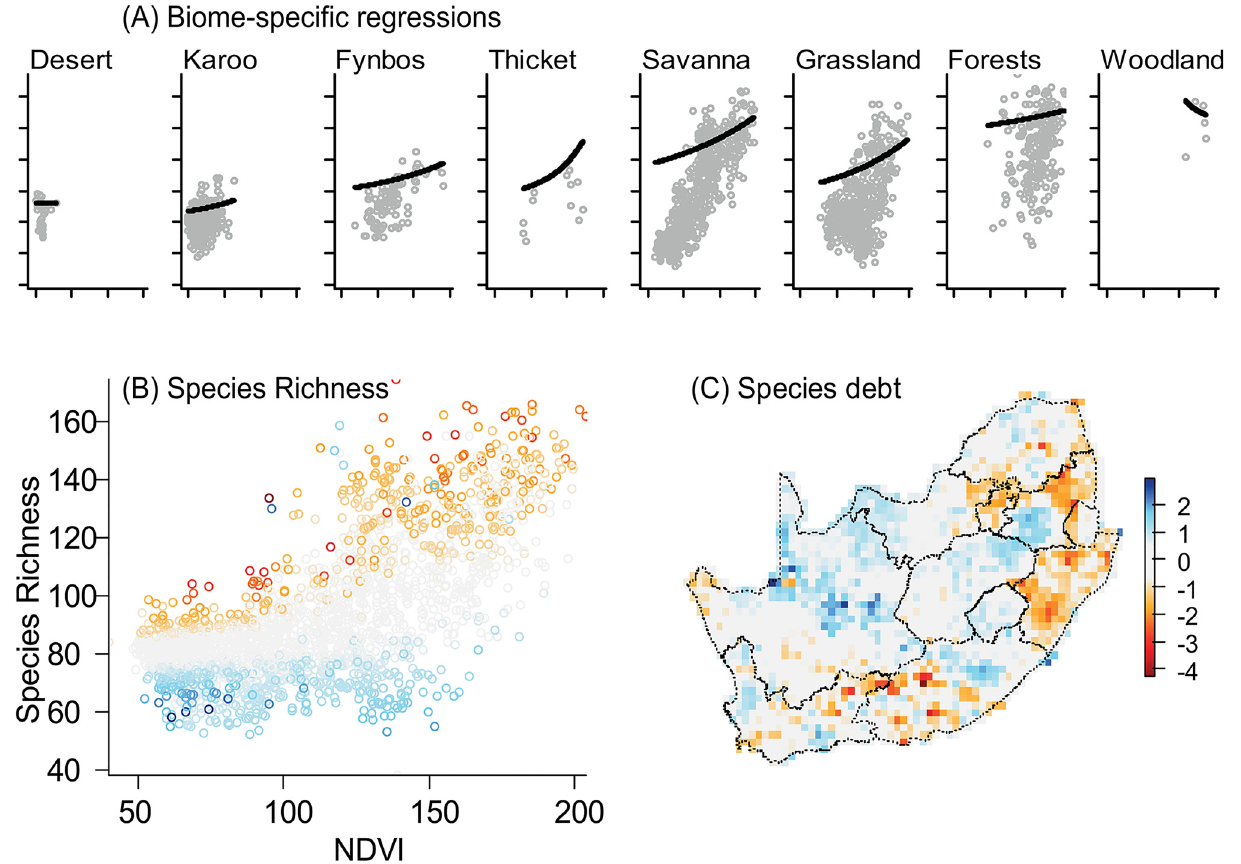
Fig 2. Relationship between passerine species richness and primary productivity (NDVI) in South Africa. (A) Separately in each biome from the westernmost biome to the easternmost one. Grey symbols represent cell-specific estimates and black lines represent the linear regressions after correcting for spatial auto-correlation and the effect of topographic heterogeneity and water availability. Axes labels as in Fig 2B. (B) Across the study region. The colour scheme refers to the species debt legend. (C) Species debt (see Species debt in the Material and Methods section for definition and computation details). Negative values (dark blue tones) indicate cells with less species than expected (species debt); positive values (orange tones) indicate cells with more species than expected (species build-up). Values used to plot Fig 2 are in S1 Table.